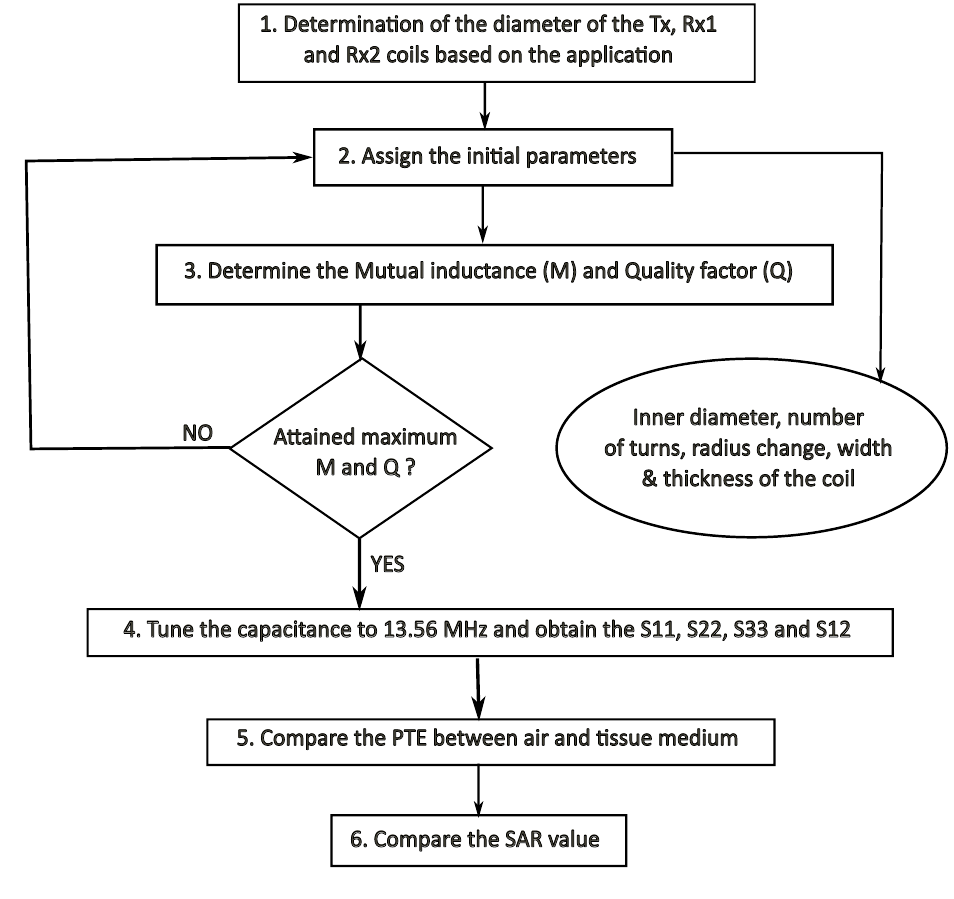
Figure 3. Flowchart of the optimization